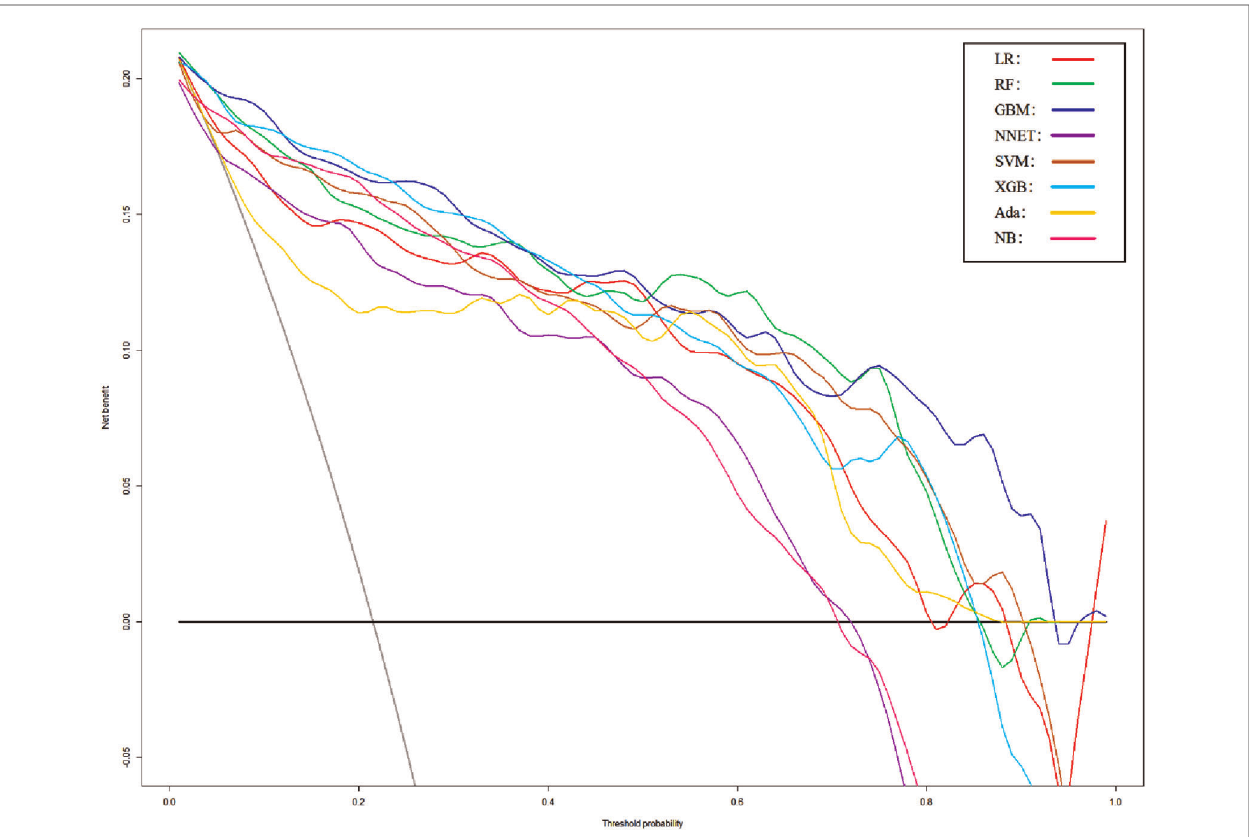
FIGURE 9 | DCA curves of different models of non-traumatic subarachnoid hemorrhage. LR, logistic regression; RF, random forest; GBM, gradient boosting machine; NNET, arti fi cial neural network; SVM, support vector machine; XGB, eXtreme gradient boosting; Ada, adapting boosting; NB, naïve Bayes; the model was adjusted for GCS, glucose, sodium, chloride, SPO 2 , bicarbonate, temperature, white blood cell (WBC), heparin use, and SOFA